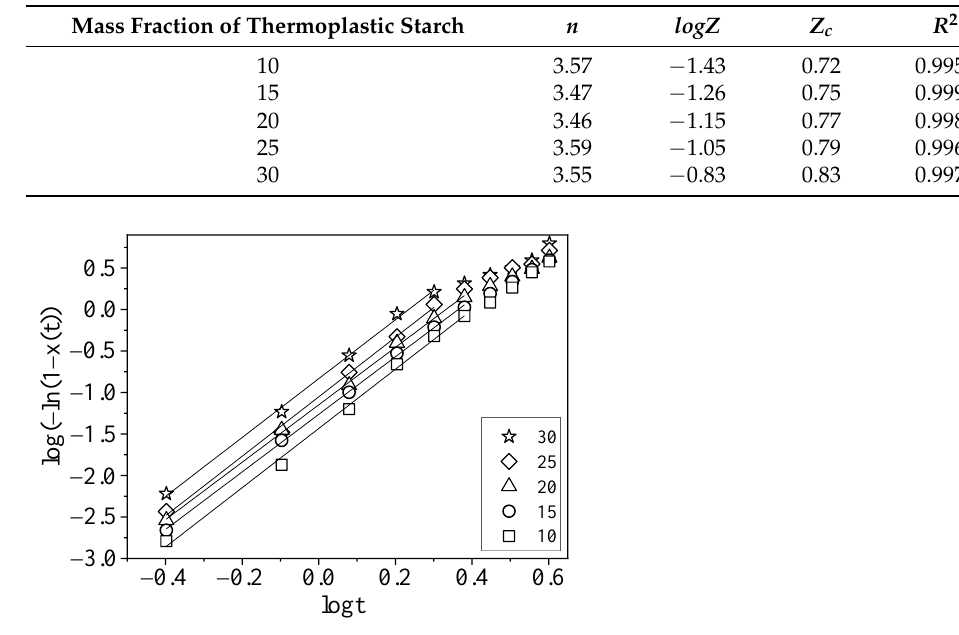
Figure 4. Plots of log [ − ln ( 1 − X ( t ))] versus logt for the nonisothermal crystallization. The symbols represent the experimental data, and the solid lines represent the fitting lines of the primary crystallization. The symbol □ is for 10 parts, ○ is for 15 parts, △ is for 20 parts, ◇ is for 25 parts, and ☆ is for 30 parts of thermoplastic starch.